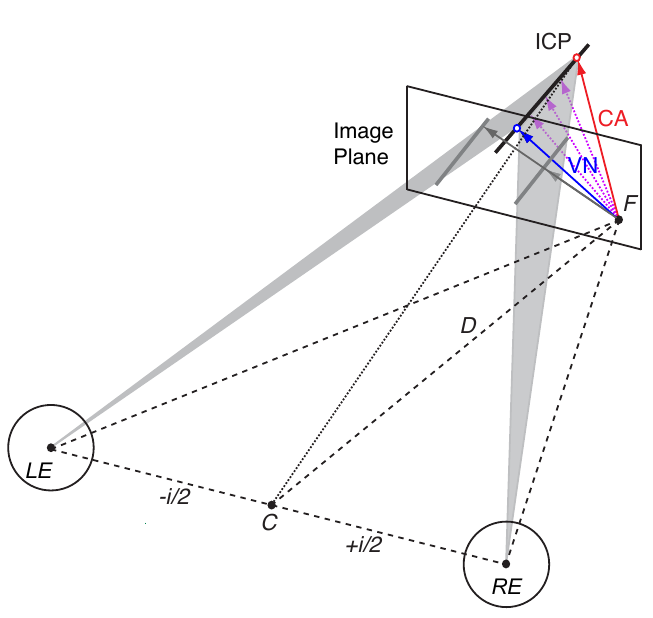
Figure 1. Illustration of velocity constraints and the 3D aperture problem. The left eye (LE) and right eye (RE), with nodal points separated by interpupillary distance i (exaggerated here), fixate point F on an image plane (screen) at distance D . Stereoscopic rendering of a tilted moving line on the image plane (grey lines) suggests two image-motion gradients (grey arrows) originating from point F . Inverse projection of each image gradient through the nodal points of each eye do not intersect but the intersection of velocity constraint planes (shaded triangles) describe all possible motion directions in a single line (ICP). Different 3D velocity estimates are shown in colour (blue—VN: Vector Normal; red—CA: Cyclopean Average; light purple – intermediate directions, see text for